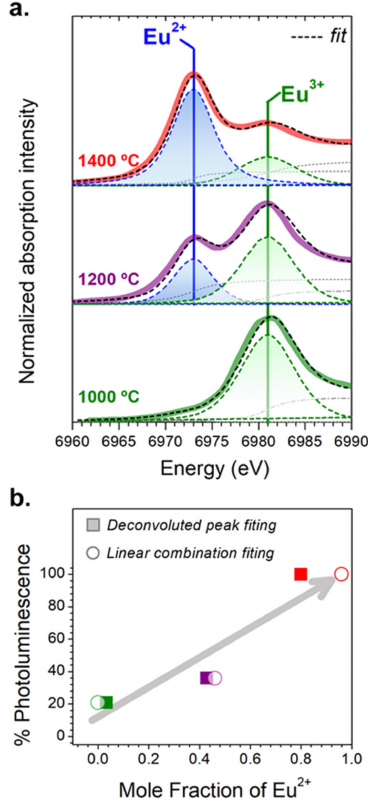
Figure 5. ( a ) X-ray absorption near-edge structure spectroscopy (XANES) measurements at the Eu L 3 -edge of the particles synthesized at 1000 (green spectrum), 1200 (purple spectrum), 1400 ◦ C (red spectrum). The fitting (black dashed curve) and the individual components (green and blue dashed curves) of the deconvoluted absorption peaks using pseudo-Voigt and arctangent step (gray dashed curves) functions are shown in the same graph. ( b ) % of photoluminescence (PL) intensity of CAO particles synthesized at 1000 (green square and circle), 1200 (purple square and circle), 1400 ◦ C (red square and circle) as a function of the Eu 2 + fraction calculated by the deconvoluted peaks and by a lineal combination fitting. The % PL intensity is referred to as the value obtained for the sample synthesized at 1400 ◦